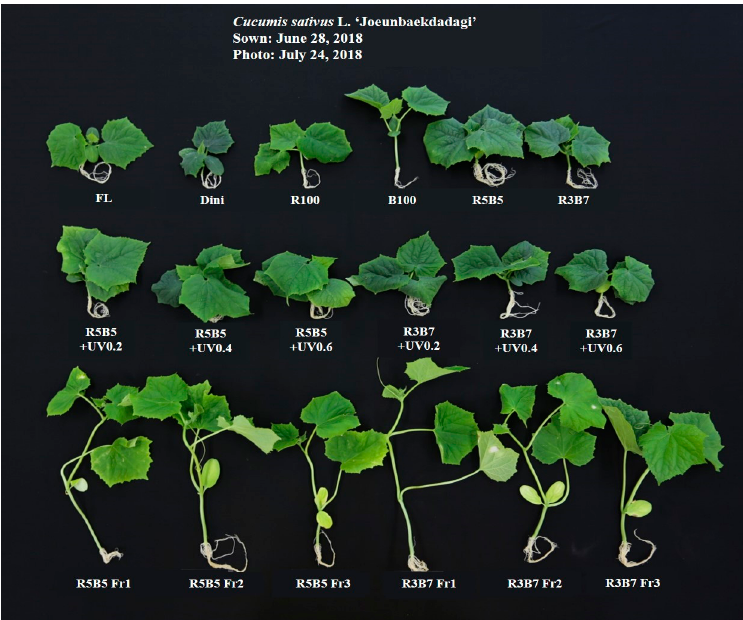
Figure 2. “Joeunbaekdadagi” cucumber ( Cucumis sativus L.) plug seedlings grown under various light qualities at 22 days after